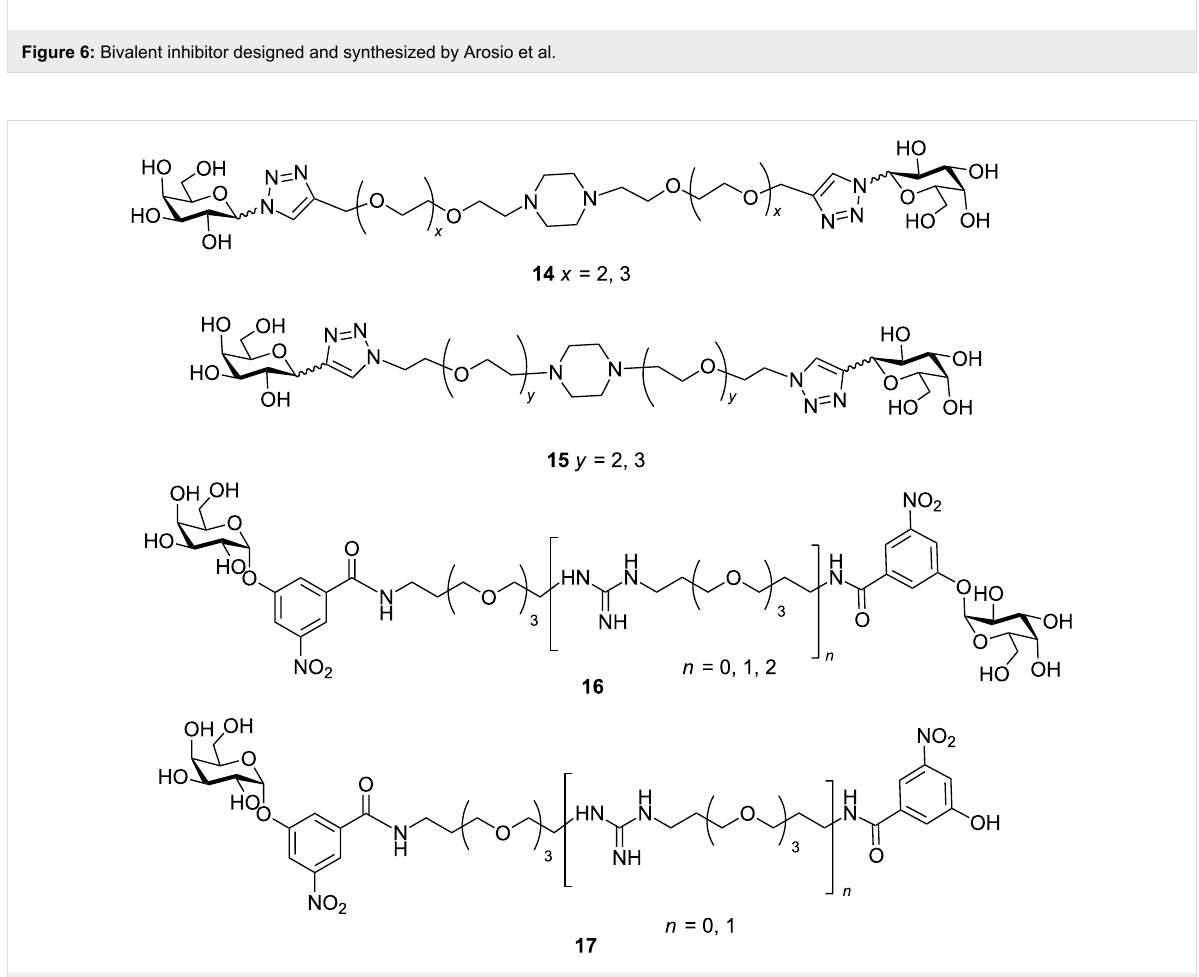
Figure 7: Bivalent inhibitors designed and synthesised by Leaver and Liu.